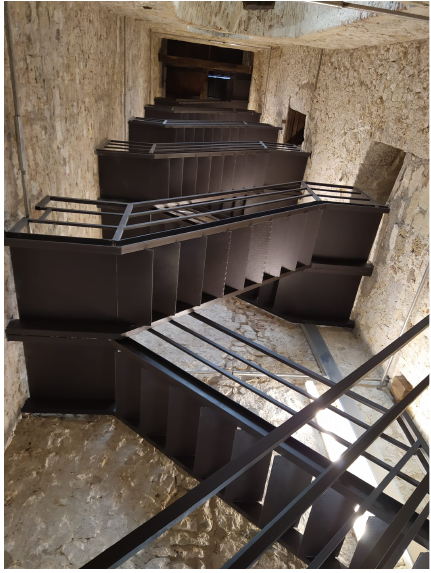
Figure 7. Interior of the belfry.